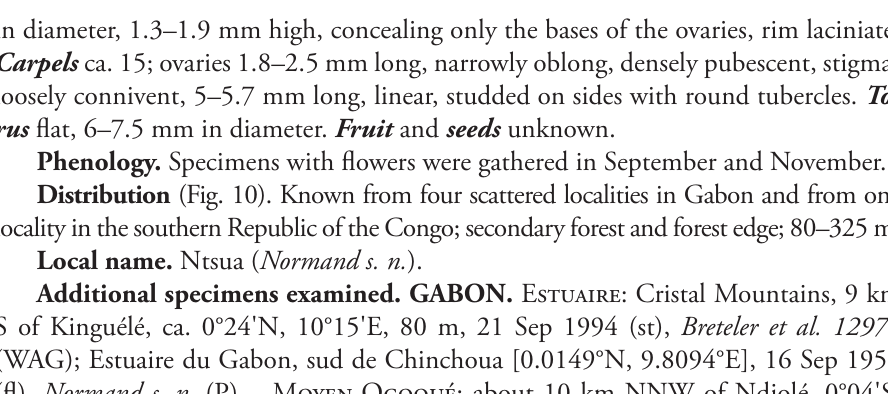
Xylopicrum rubescens (Oliver) Kuntze, Revis. gen. pl. 1: 8. 1891. Type. NIGERIA [“Upper Guinea”]. Rivers, Old Calabar, s. d., W. C. Thomson 53 (holotype: K!